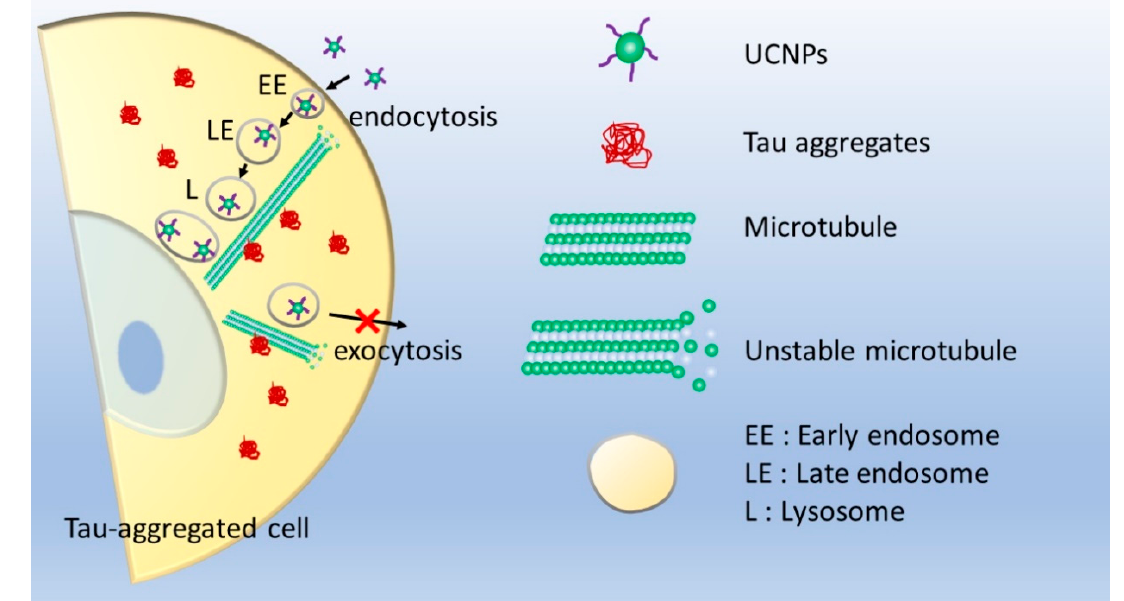
Figure 7. Schematic presentation of endocytosis and exocytosis of ~100 nm size surface functionalized UCNPs in tau- aggregated neuron cells.